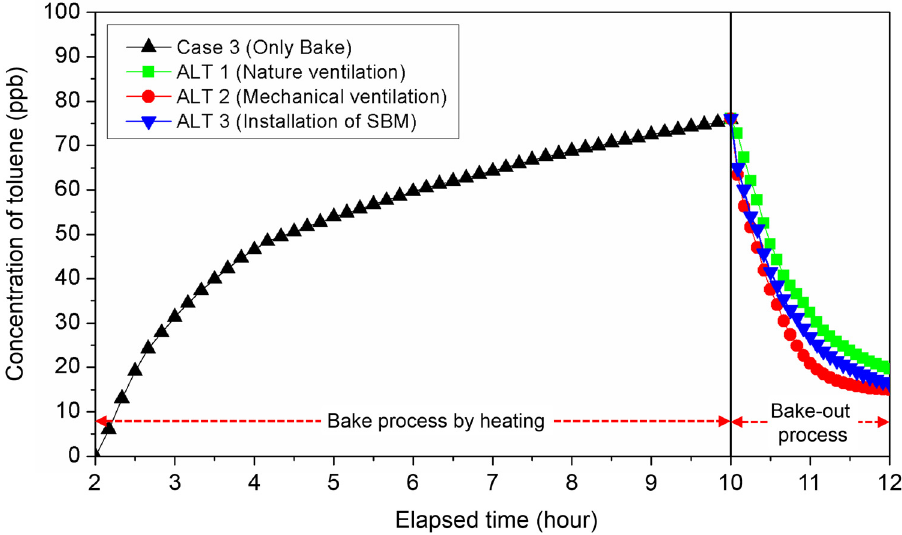
Figure 9. Concentration of pollutant during Bake-out process using CFD (computational fluid dynamics) analysis. SBM: sorptive building material.